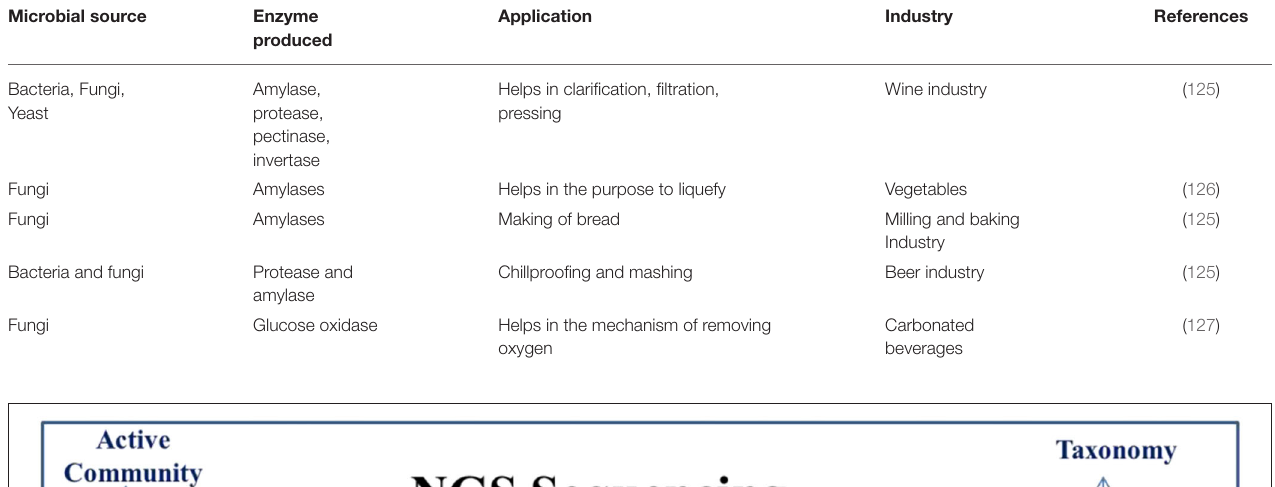
TABLE 1 | Microbial enzymes having utility at various food processing industry.